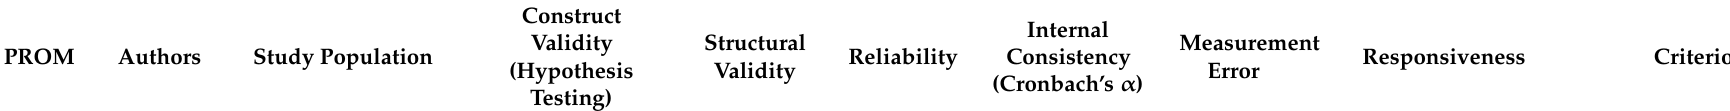
Table 7. Summary of the measurement properties of 3Q/TMD: Three screening questions for Temporomandibular Disorders (3Q/TMD)